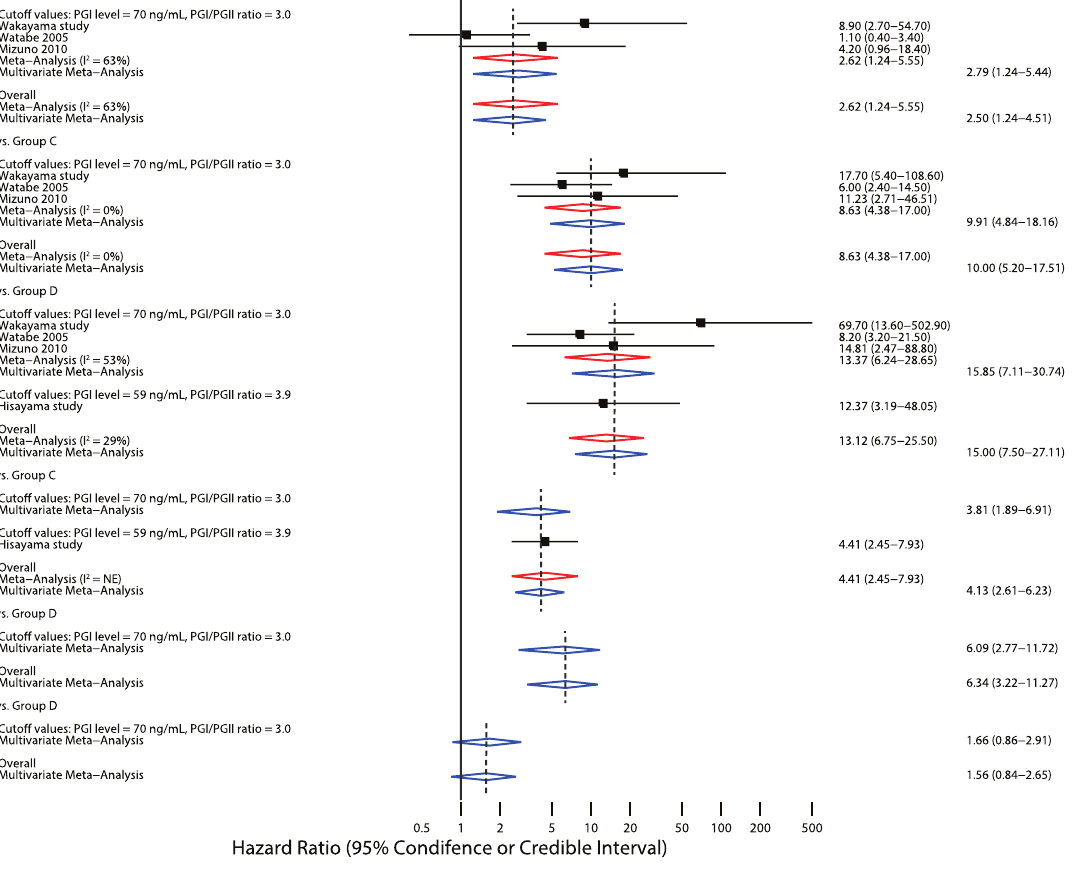
Figure 2. Meta-analysis of hazard ratio for four-risk-group prediction model to predict gastric cancer development. The red and blue diamonds depict a summary hazard ratio with extending 95% confidence interval (CI) or 95% credible interval (CrI), estimated from direct meta- analysis or multivariate meta-analysis, respectively. Each square and horizontal line indicates the hazard ratio and corresponding 95% CI, respectively, for each study. NE=not estimable.